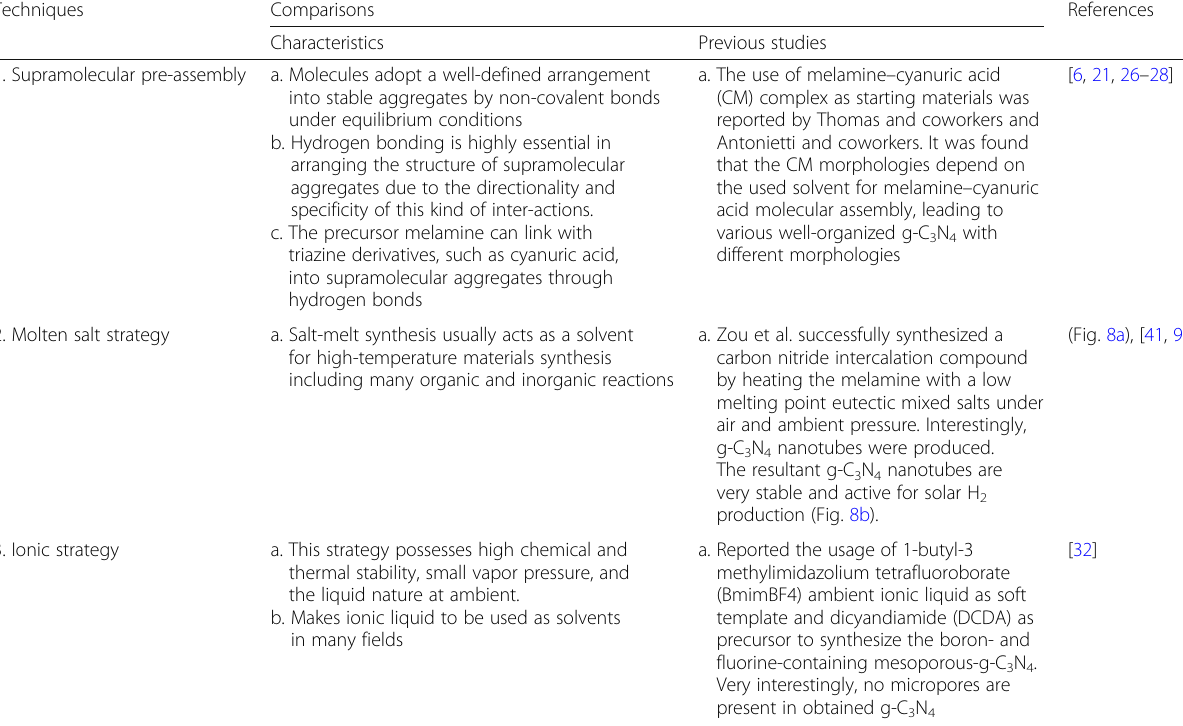
Table 3 Comparisons of some selected Fabricating strategies of g-C 3 N 4 synthesis Techniques